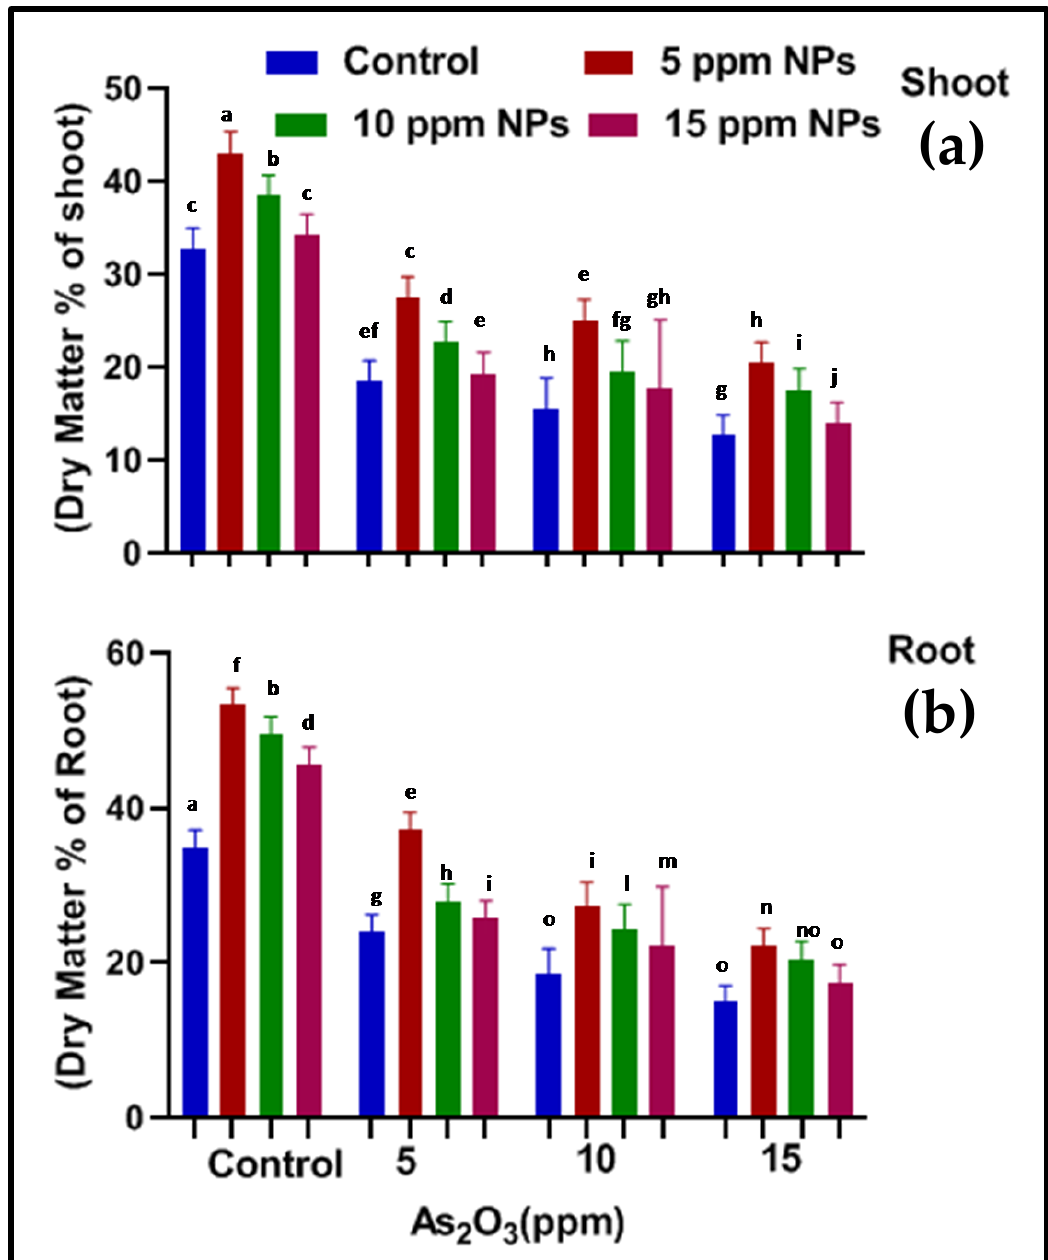
Figure 7. Effect of Bacillus subtilis -synthesized Fe 3 O 4 NPs on ( a ) shoot ( b ) root dry matter % of rice ( Oryza sativa L.) in arsenic-contaminated water. Different letters show a significant difference at p < 0.05 between treatments.